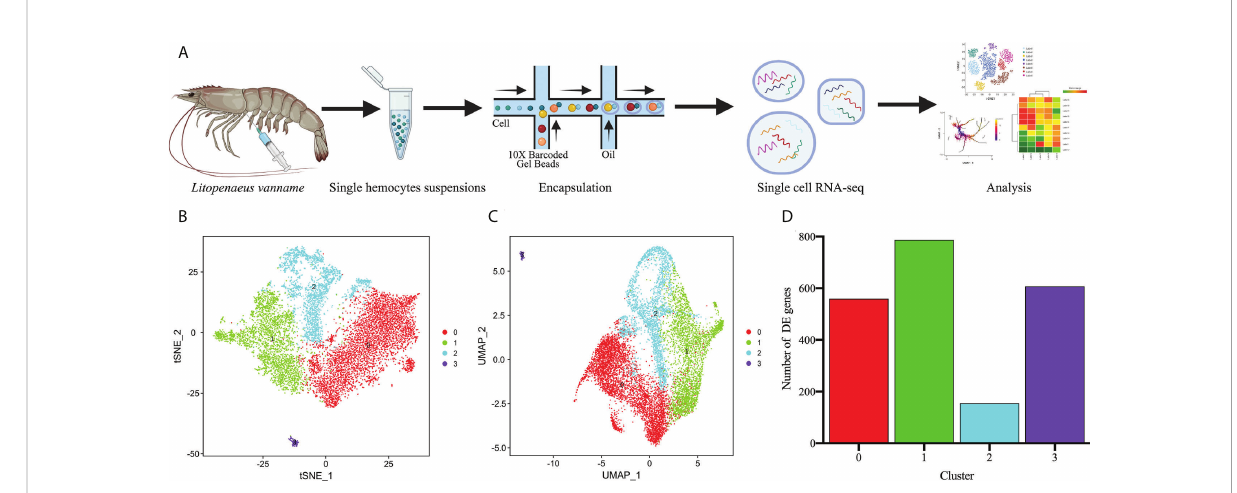
FIGURE 1 Single-cell RNA-Seq of Litopenaeus vannamei hemocytes reveals diverse cell types. (A) Overall work fl ow for schematics of the micro fl uidics- based scRNA-seq. (B) The t-Distributed Stochastic Neighbor Embedding (t-SNE) dimensional reduction was used to visualize the classi fi cation results of L. vannamei hemocytes. The hemocytes were clustered into four populations using the clustering algorithm based on graph theory. (C) The uniform manifold approximation and projection (UMAP) was utilized for the re-clustering analysis and visualization of hemocytes. See Supplementary Figure 2. (D) Statistics on the number of differentially expressed genes among different hemocyte